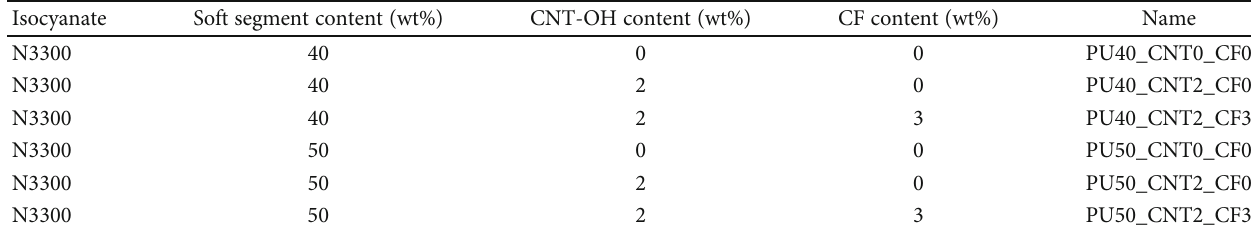
Figure 1: The block scheme of experimental procedure to prepare. Table 2: Types of samples prepared for self-healing study and their